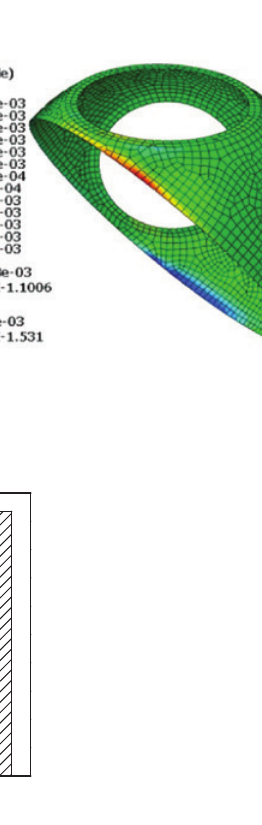
Figure 9: Mechanical properties of the two fabricated materials for force-bearing structures: (A) compression strength and (B) ILSS.